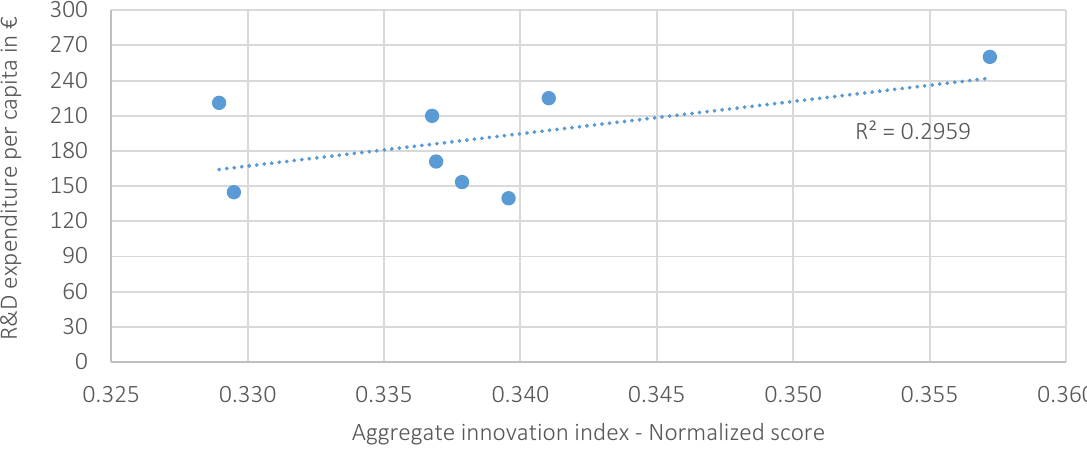
Figure 5. Correlation analysis – Hungary